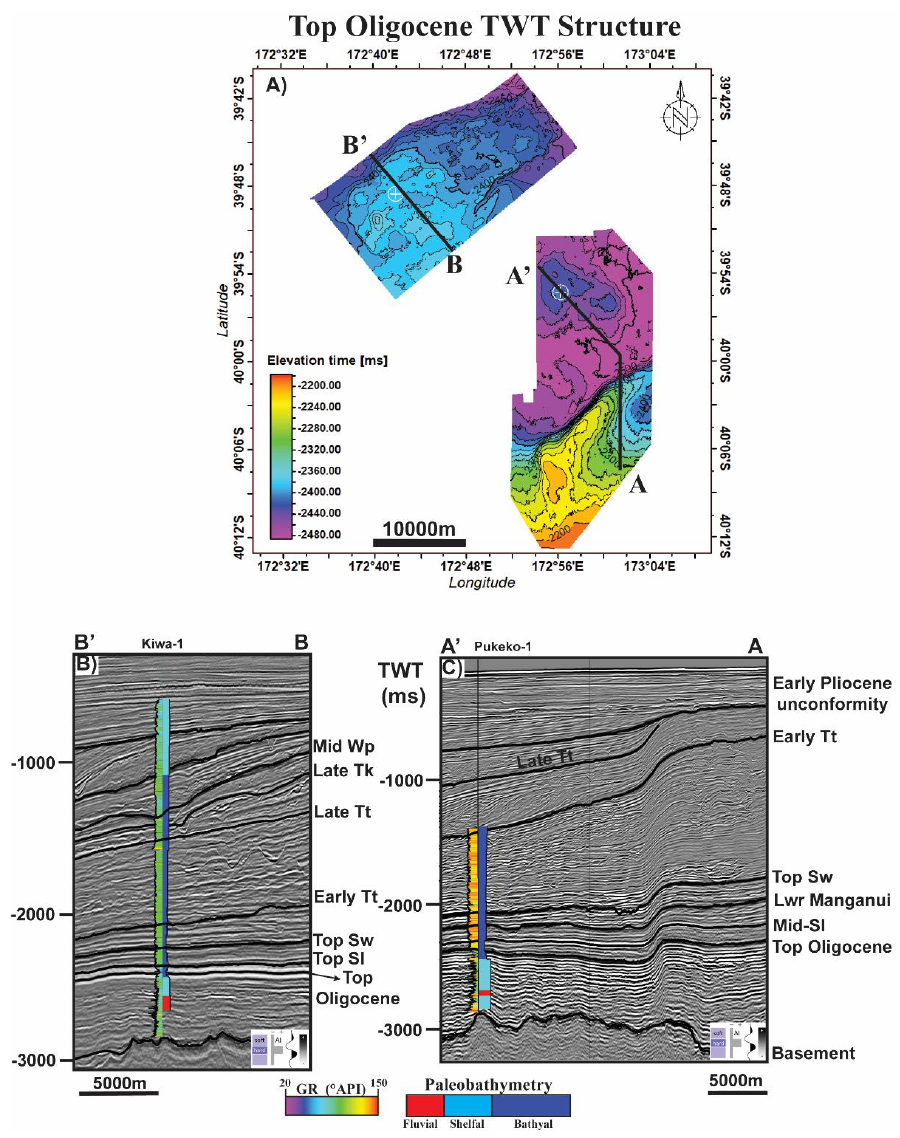
Figure 3. ( A ): Top Oligocene TWT structure map of the Pipeline-3D and Hector-3D seismic surveys. ( B ): Arbitrary line along depositional dip through the Hector 3-D seismic survey with interpreted horizons shown. The Hector-1 well is shown with measured gamma ray log and paleobathymetry log. ( C ): Arbitrary line through the Pipeline-3D seismic survey with interpreted horizons shown. The Pukeko-1 well is shown with measured gamma ray log and paleobathymetry log.